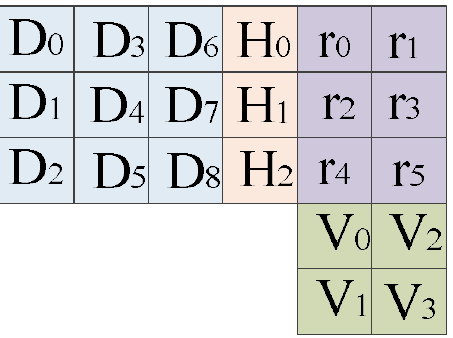
( c ) Figure 20. SRAM cell hardening for soft errors mitigation. ( a ) Increasing critical charge value [68]; ( b ) indirect connection to internal nodes [69]; ( c ) external components to slow down response [70].